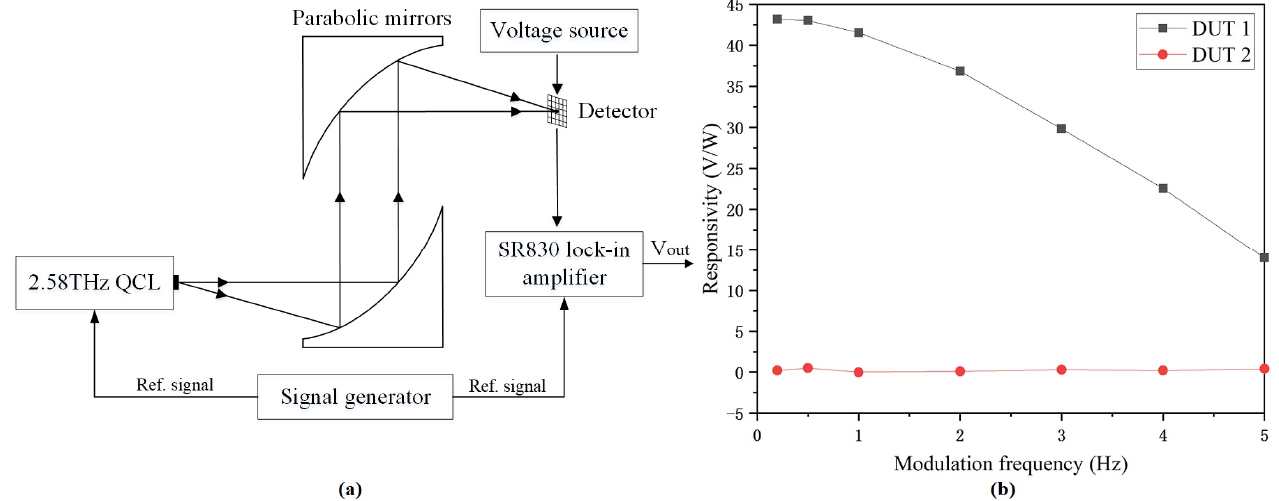
Figure 7. ( a ) Output voltage measurement setup as detectors operate at 2.58 THz. ( b ) Responsivities.